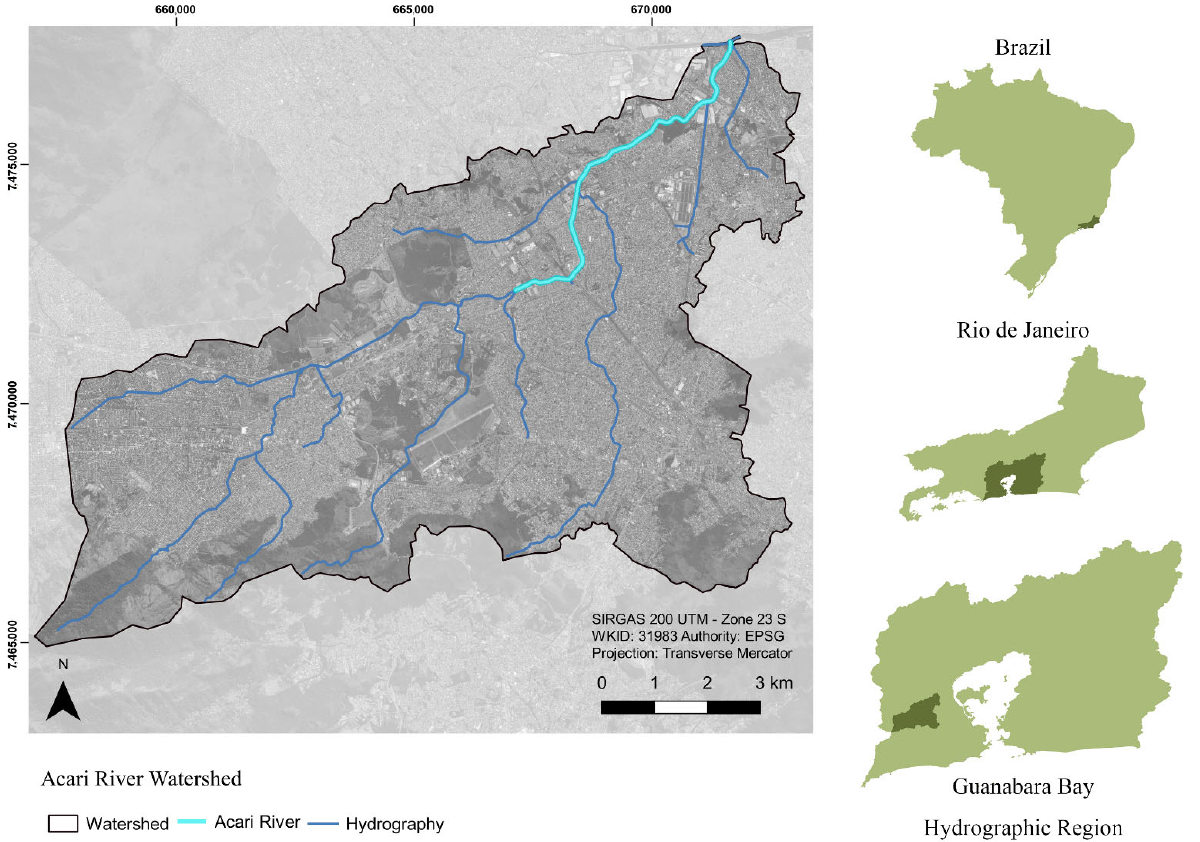
Figure 2. Acari River watershed.